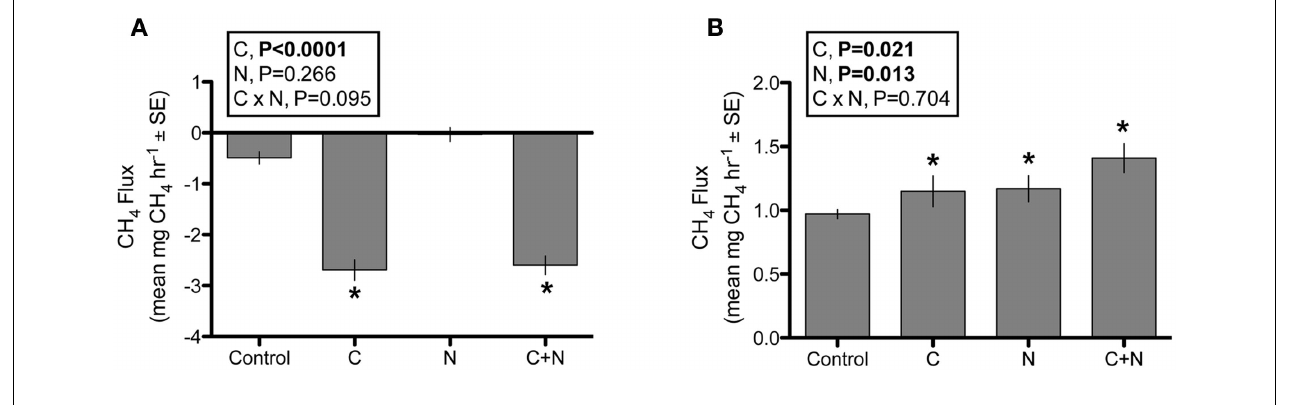
replicates per treatment/group, N = 48. Error bars were constructed using 1 SEM. Results of the two-way ANOVA are reported in